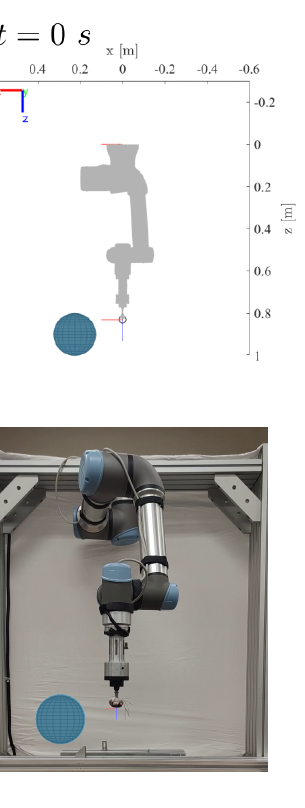
Figure 14. Test case 3: avoidance of a dynamic obstacle interfering with the end-effector in a fixed position, Mode I. Simulated ( top ) and real ( bottom ) motion of the robot.